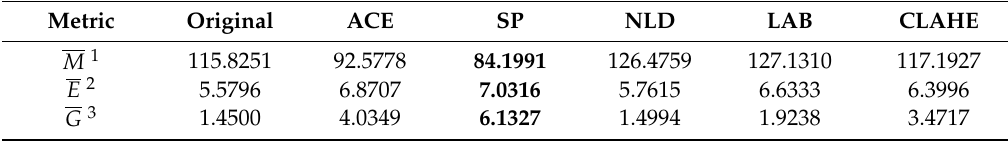
Table 4. Average metrics for the sample image “CalaMinnola2” enhanced with all algorithms. Metric Original